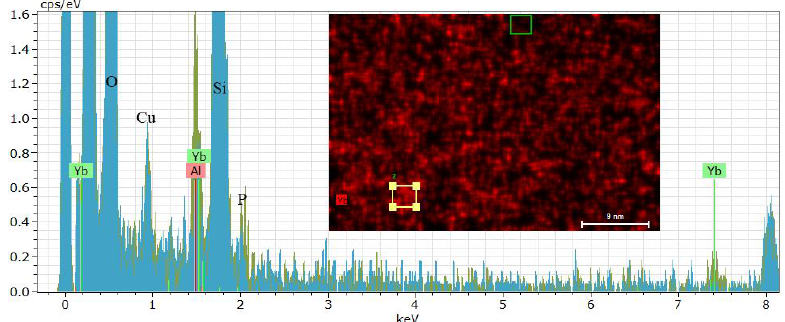
Figure 11. EDX spectra from a clustered area (green) and a free cluster zone (blue): the visible signal from Yb atoms within the clustered area